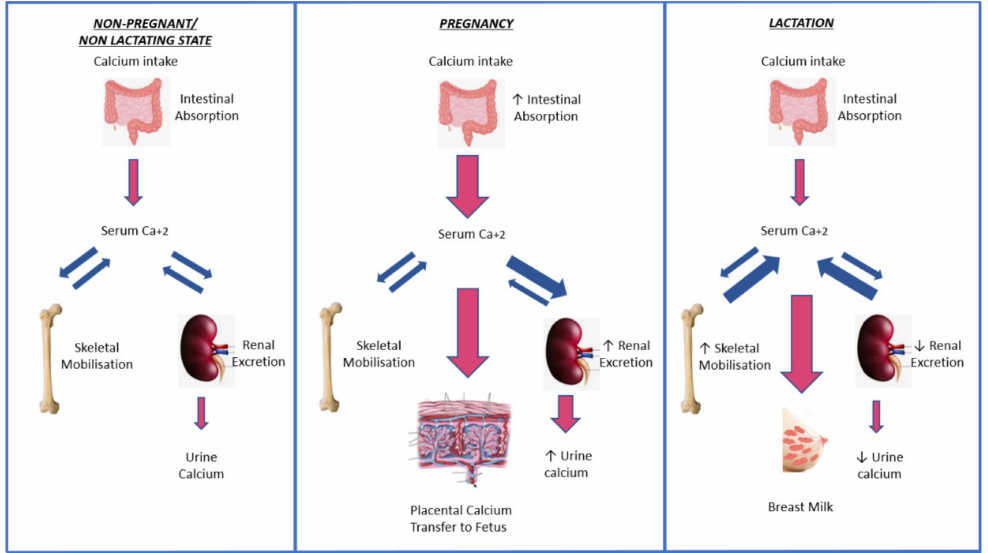
Figure 1. Physiological calcium changes during pregnancy and lactation. Doubles arrows denote reciprocal relationship which single arrows denote increase and